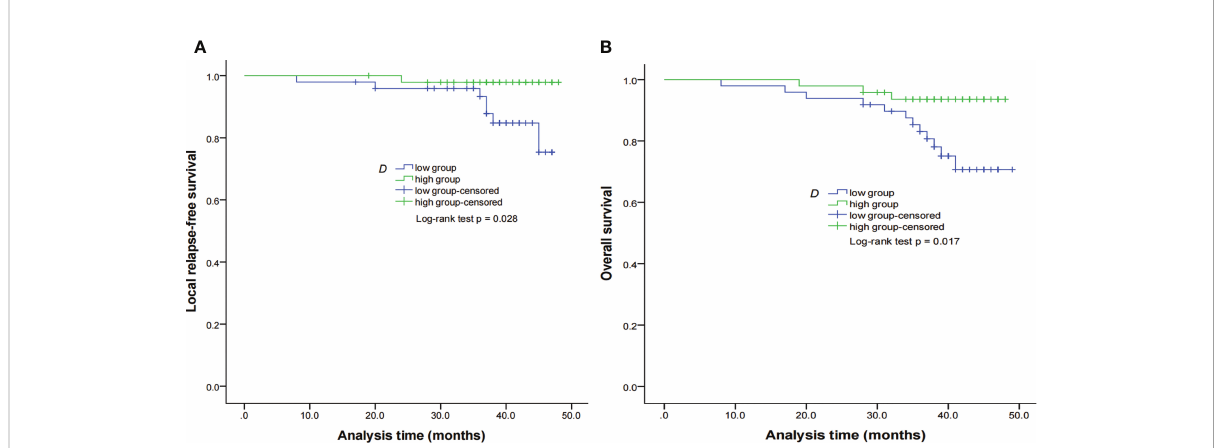
FIGURE 3 Kaplan – Meier curves of LRFS (A) and OS (B) for NPC patients strati fi ed as the low D and high D groups. Low D group = patients with a primary lesion pretreatment D value ≤ 0.699 × 10 − 3 mm 2 /s; high D group = patients with a primary lesion pretreatment D value > 0.699 × 10 − 3 mm 2